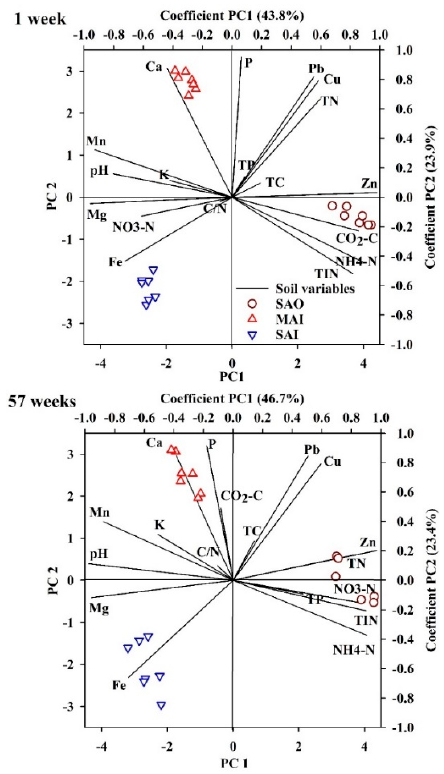
Figure 2. Principal component analysis at the first week and 57th week of the incubation period, based on soil chemical characteristics and cumulative CO 2 -C, in the SAO, MAI and SAI soils. Each soil underwent seven treatments, and each treatment involved five replicates. The database of cumulative CO 2 -C was abstracted from the previous study [14].